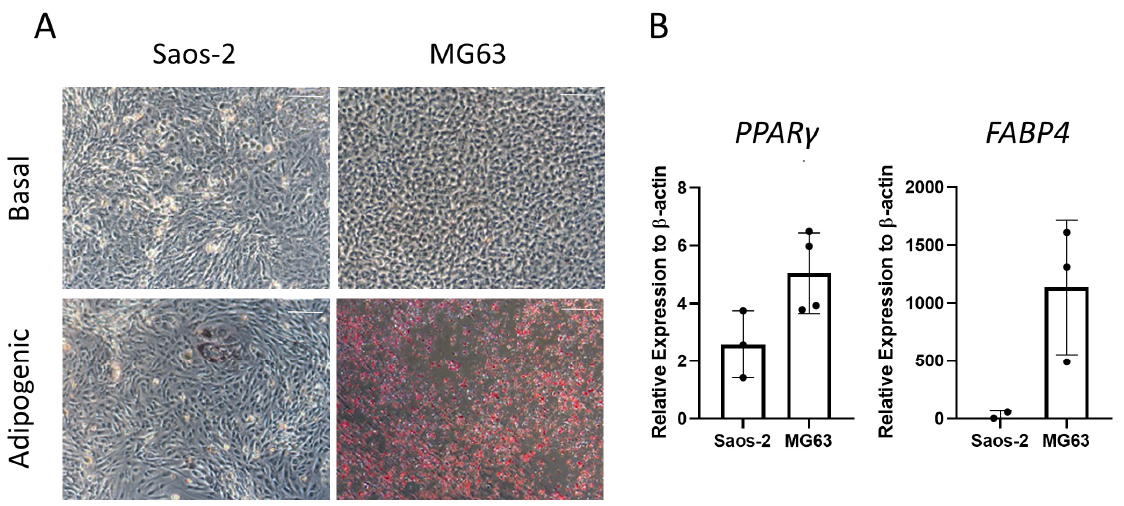
Figure 8. Adipogenic differentiation of two osteosarcoma cell lines. Two osteosarcoma cell lines Saos-2 and MG63 were cultured in basal or adipogenic media for 14 days. ( A ) Adipogenic cells produce lipid droplets, which are stained by the oil red O (red). Scale bar = 100 µ m. ( B ) Gene expression analysis of FABP4 and PPAR γ in the osteosarcoma cell lines was performed by qPCR, n = 3–4, symbols refer to individual patient samples with three technical replicates. Results are presented as mean +/ − SD, significance determined using a one-way ANOVA, no significance found.